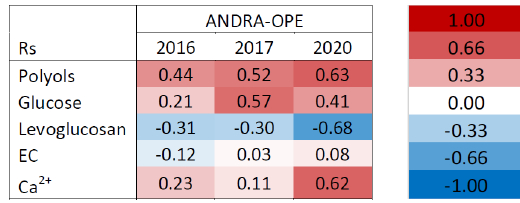
Table 8. Spearman correlations ( R s ) between cellulose and charac- teristic chemical tracers at ANDRA-OPE, across the three separate sampling periods: 2016, 2017, and 2020. A red cell indicates a pos- itive correlation between cellulose and the selected chemical tracer, whilst a blue cell indicates a negative correlation. A colour-coded key of corresponding R s values is to the right of the table. Note that polyols row represents the sum of arabitol, mannitol, and